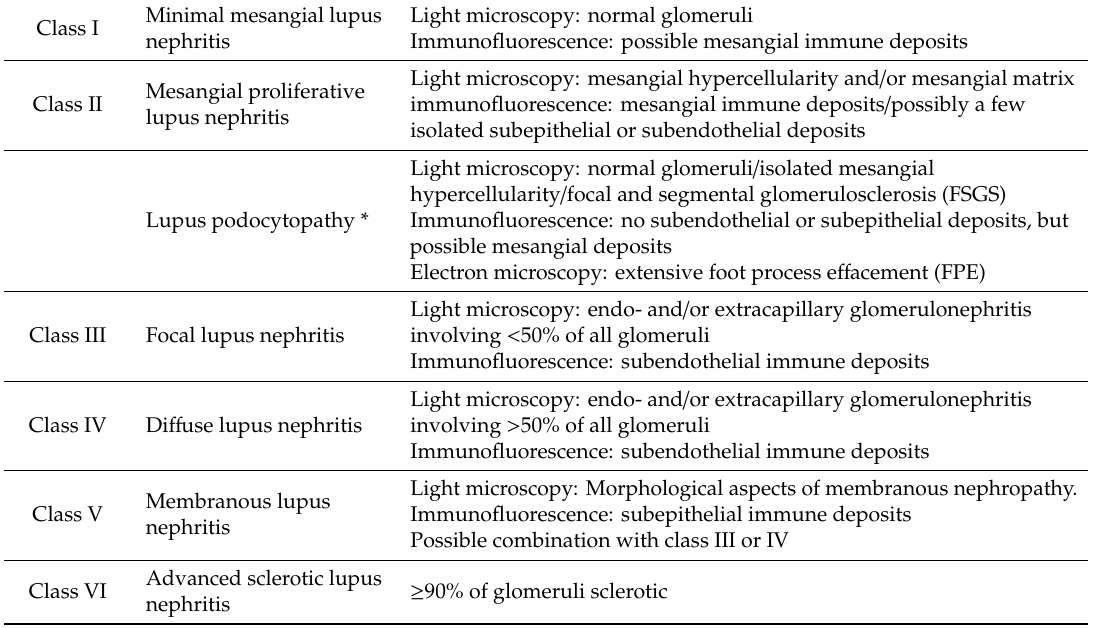
Table 1. International Society of Nephrology / Renal Pathology Society (ISN / RPS) lupus classification and definition of lupus